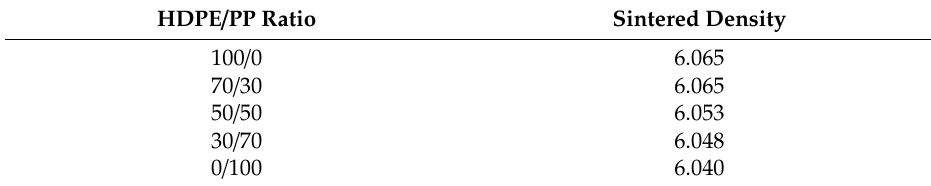
Table 5. Ceramic densities after sintering process of 50 vol% filled HDPE / PP / wax blends. Note that the maximal theoretical density of zirconia ceramic is